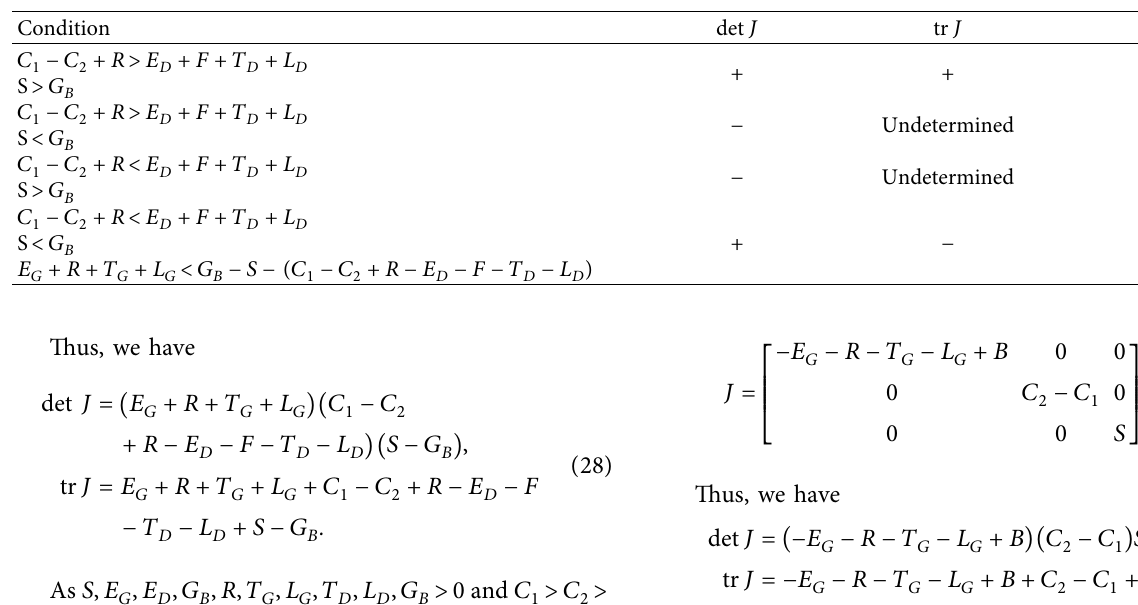
Table 6: Stability discussion of point G (1, 0,